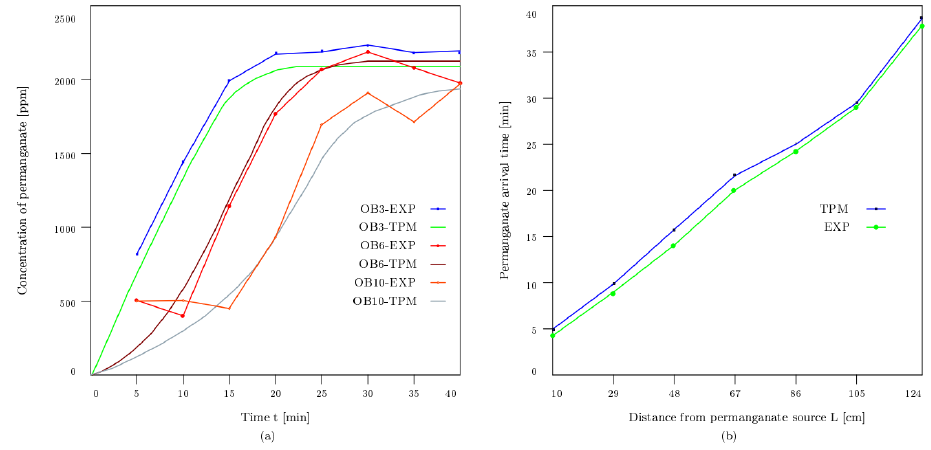
Figure 7. The comparison between measured and eTPM predicted permanganate ( a ) concentration ( b ) arrival